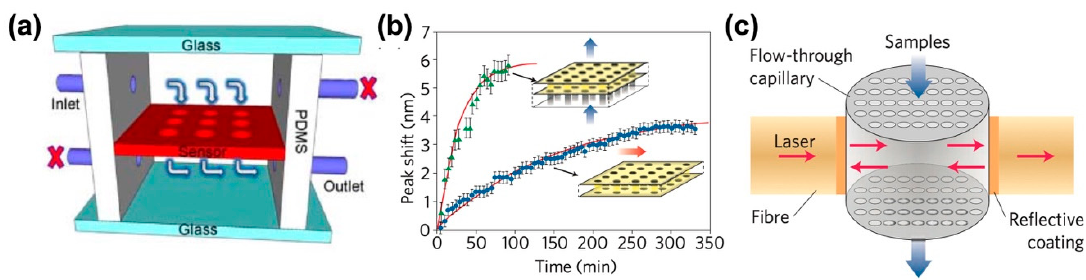
Figure 1. Nanofluidic devices using photonic structures for RI sensing: ( a ) nanohole array with “flow- through” scheme (adapted with permission from [37]. Copyright 2009 Optical Society of